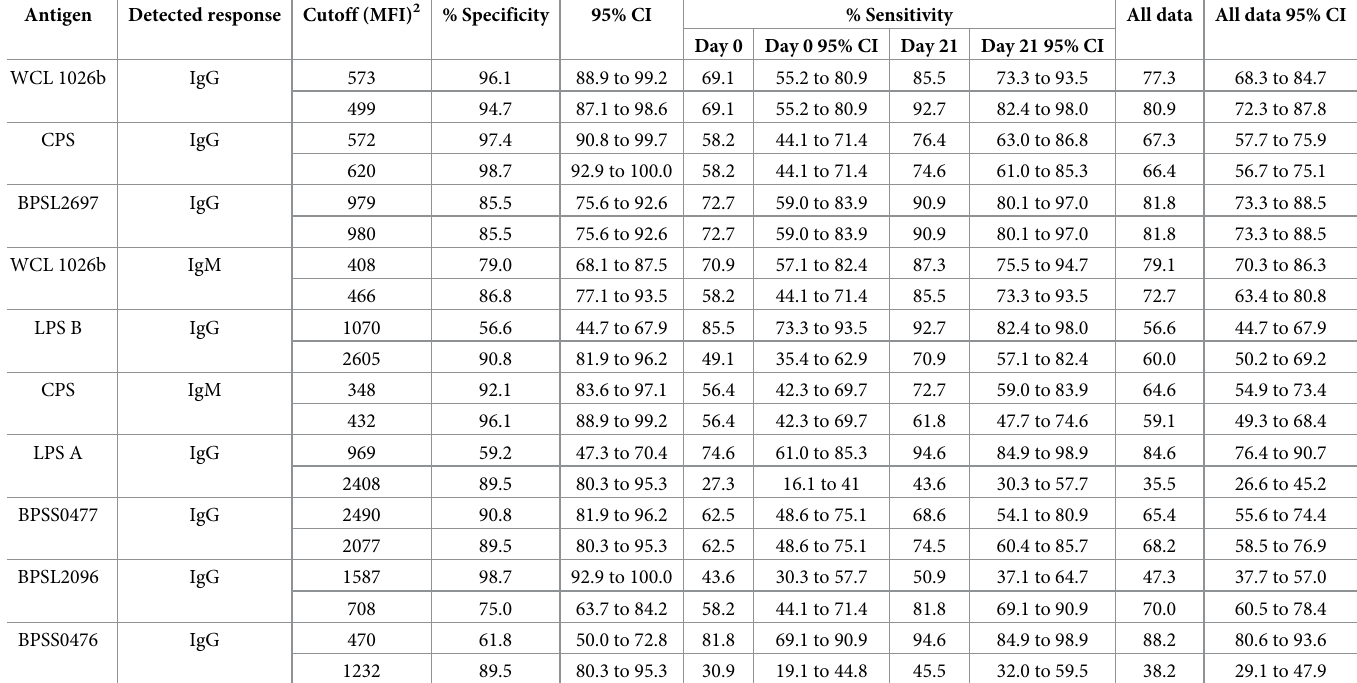
CPS and at the lowest was around ~59% for LPS depending on the assay cutoff employed. For sensitivity, the highest sensitivity was ~84% for LPS A but could be as low as 35% for the same antigen depending on the cutoff used. The sensitivity increased for each antigen when looking at sample collected later during infection. There are several individual antigens that could be used to diagnose melioidosis patients and diagnostic performance of these antigens varies. Table 3. Sensitivity and specificity of the top 10 individual antigens or WCL conjugated to Luminex microspheres 1 . Antigen Detected response Cutoff (MFI) 2 %